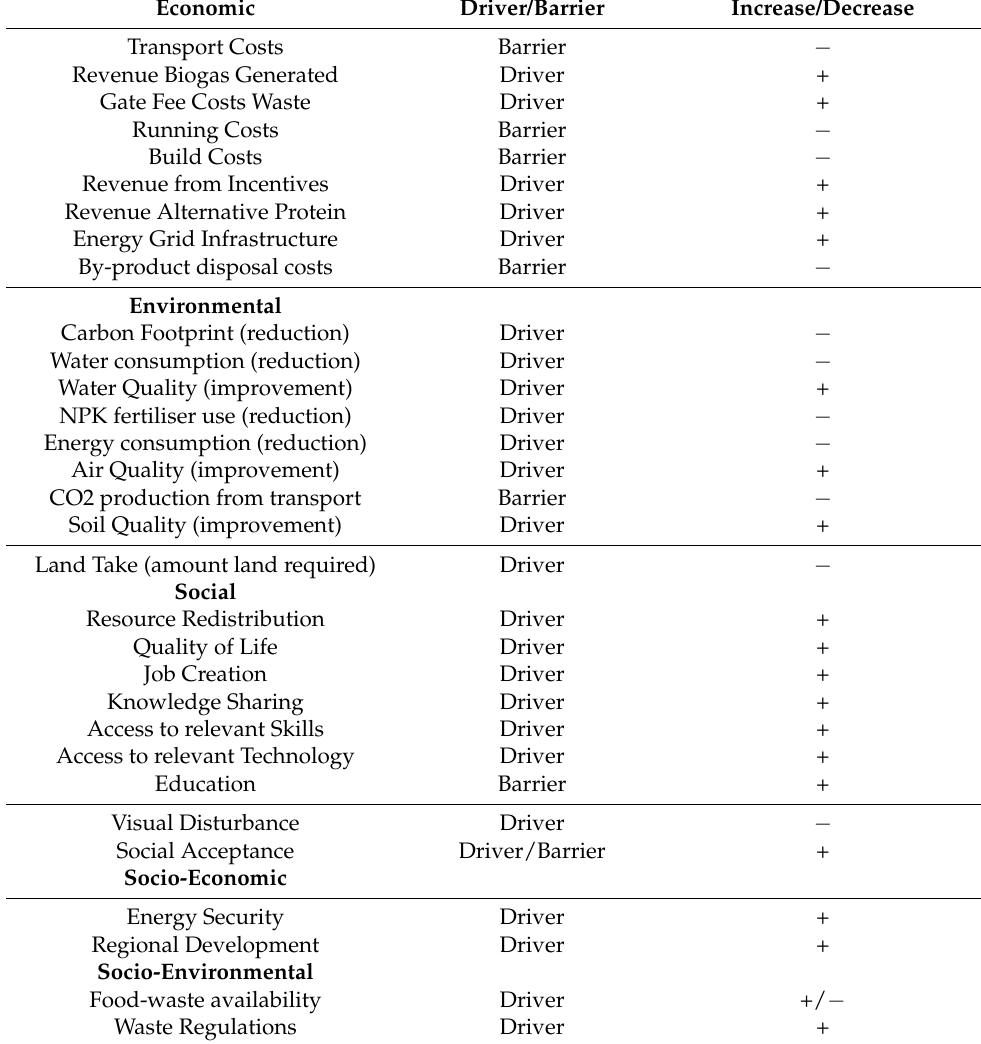
Table 2. Sustainability